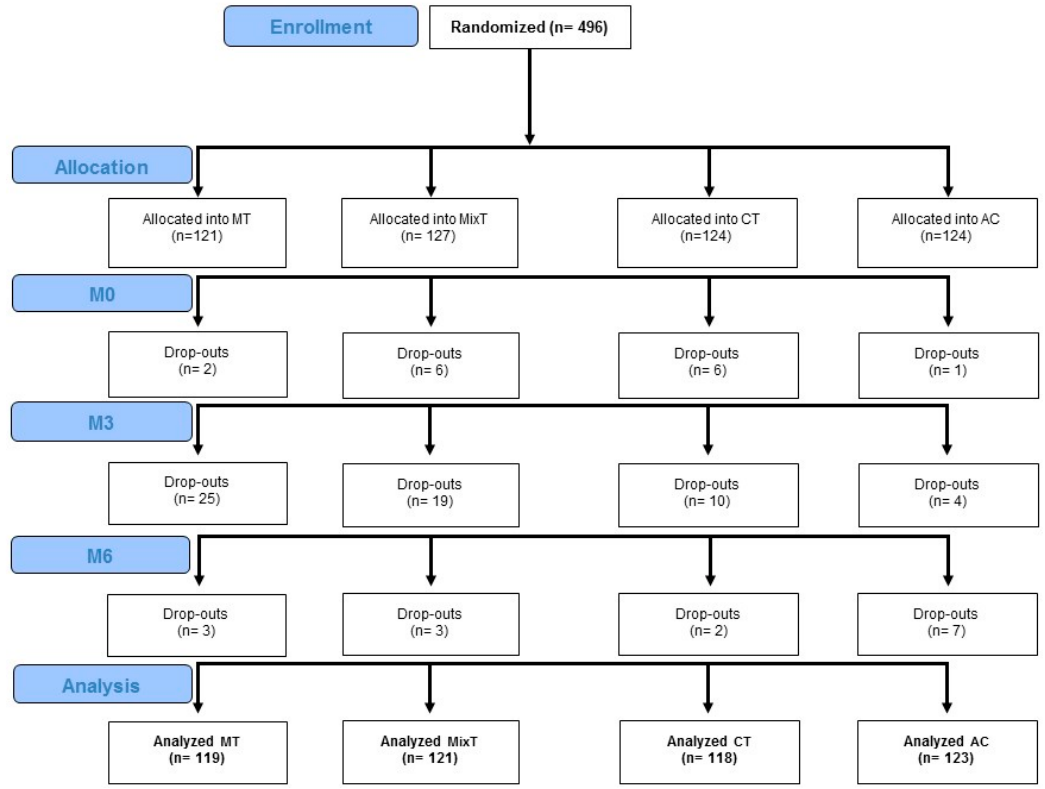
Figure 1. Flow chart of participants in the study showing the allocated and analyzed participants and drop-outs in the four arms of the study and the three multidimensional assessments before: the onset of the treatment, at the end of the treatment after 3 months (M3) and after other 3 months of follow-up (M6). Abbreviations: MT: motor treatment; MixT: mixed treatment; CT: cognitive treatment; AC: active control.